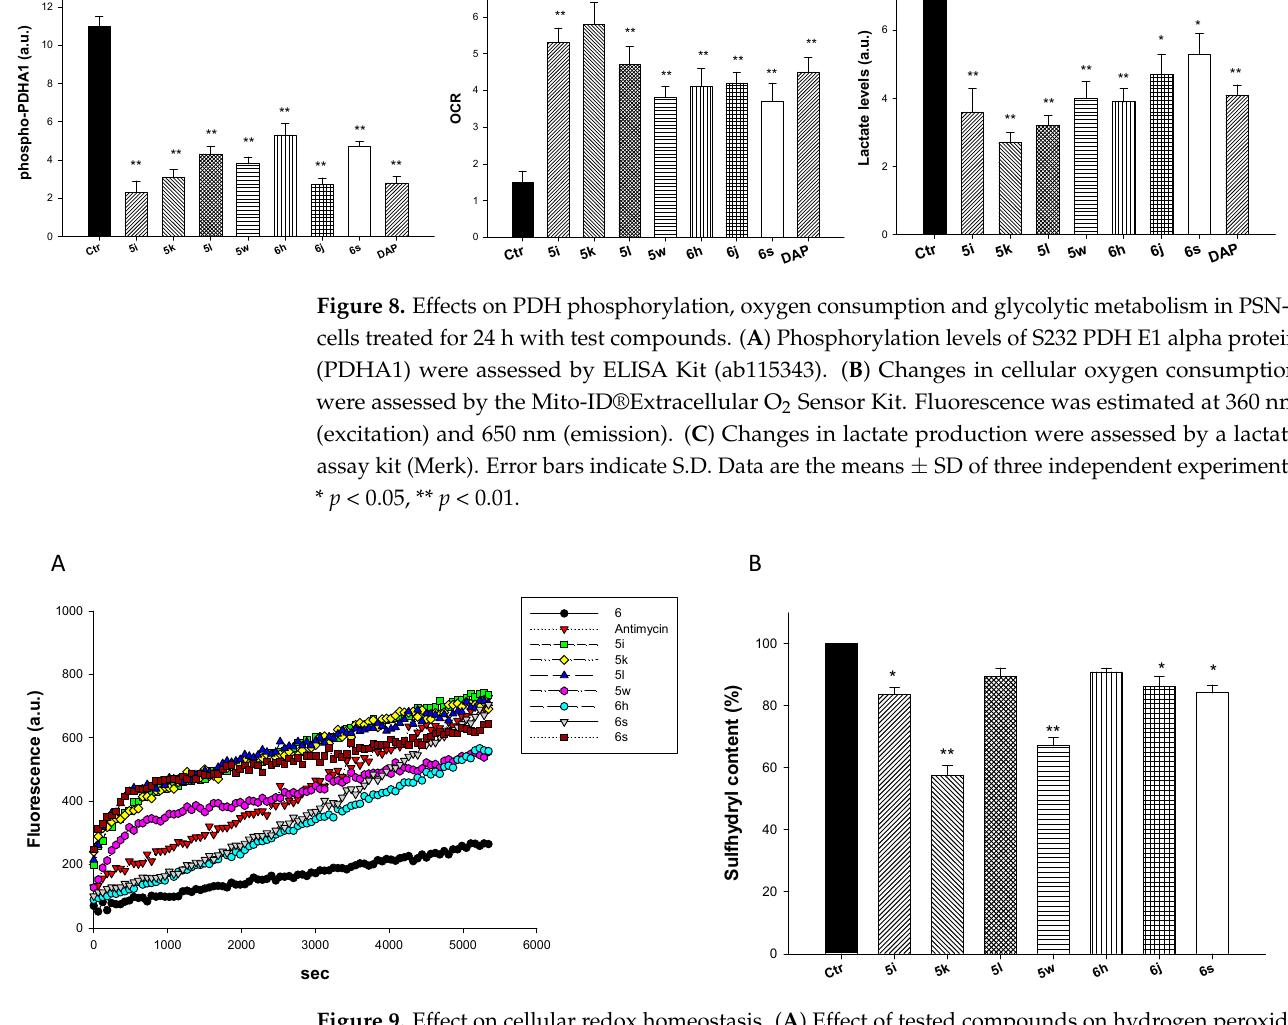
Figure 9. Effect on cellular redox homeostasis. ( A ) Effect of tested compounds on hydrogen peroxide formation in PSN-1 cells. Cells were pre-incubated in PBS/10 µ M glucose medium for 20 min at 37 C in the presence of 10 nM CM-H 2 DCFDA and then treated with 5 µ M of test compounds or antimycin (3 µ M). ( B ) Cellular thiol redox status. Sulfhydryl content in PSN1-treated cancer cells incubated for 24 h with test compounds. The sulfhydryl group amount was determined by the DTNB assay. Error bars indicate S.D. Data are the means ± SD of three independent experiments. * p < 0.05, ** p < 0.01.